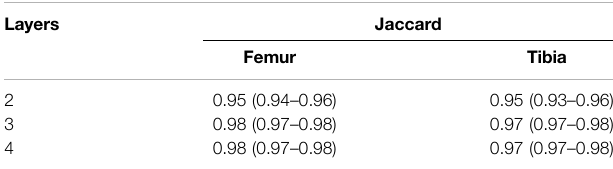
TABLE 3 | Results (median and IQR values) of the ablation test performed on the CEL-Unet and a different number of convolutional